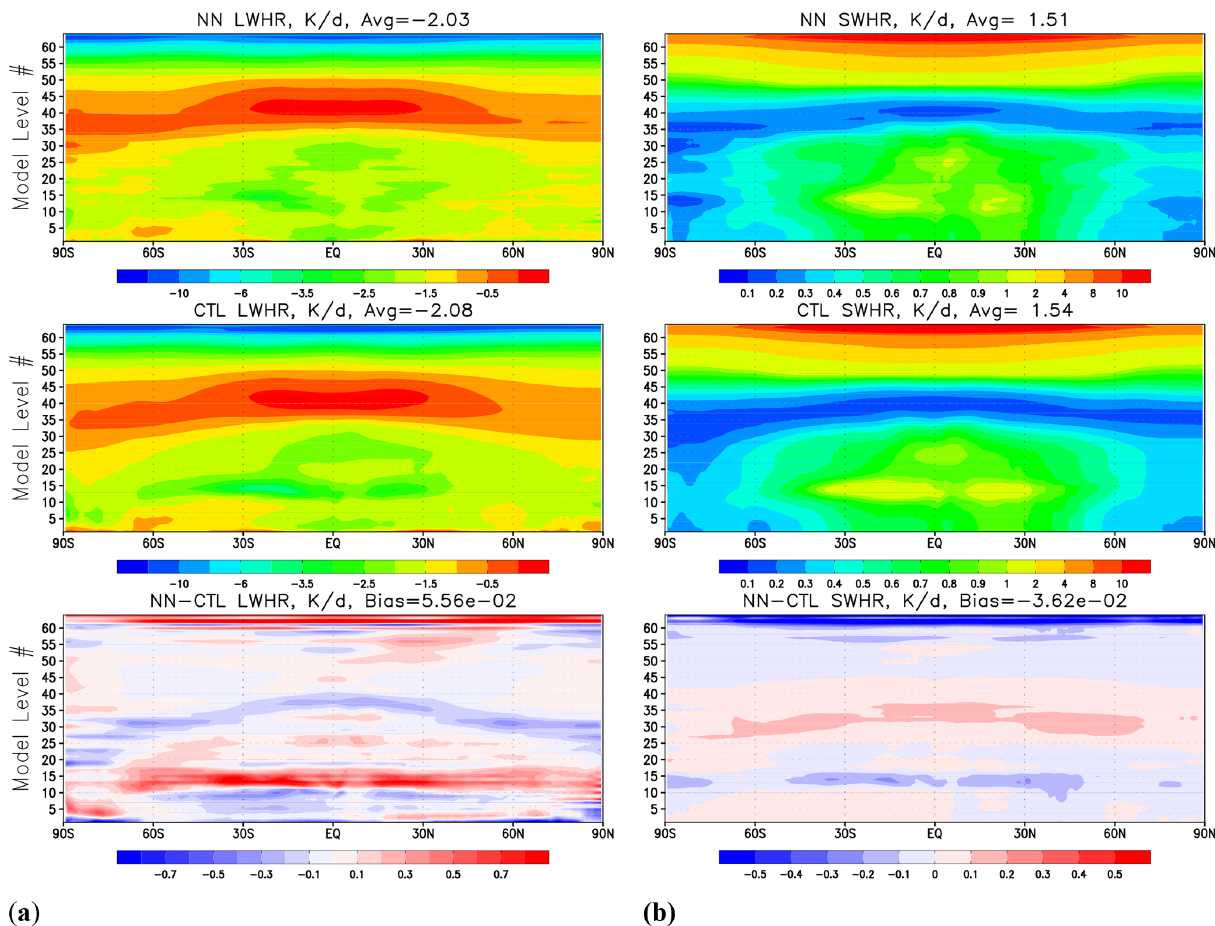
Figure 1. Zonal and time mean over 12 months’ worth of model output covering 1 February 2018–1 February 2019 for (a) longwave heating rate (Kd − 1 ) and (b) shortwave heating rate (Kd − 1 ). Upper row – results produced by HGFS; middle – results by GFS; lower row: the difference (HGFS − GFS). The vertical coordinate shows the model level